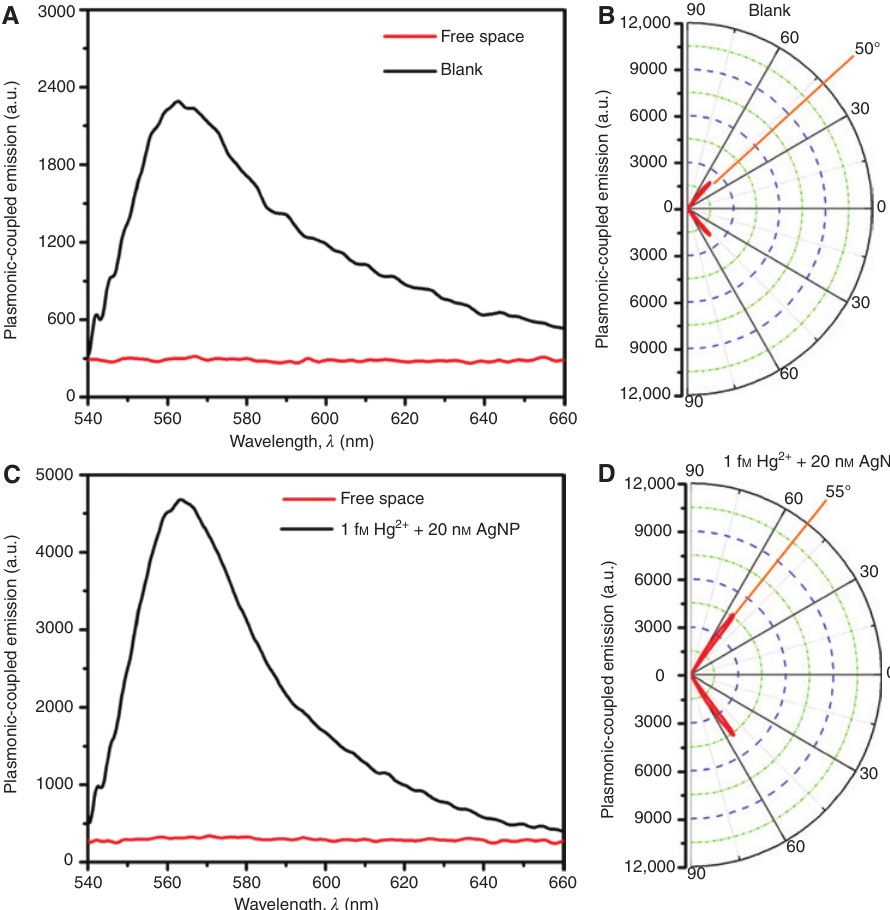
Figure 5: In the presence of the AgNP spacer layer, (A) SPCE and FS intensity of Rh6G D in the absence of Hg 2 + ; (C) SPCE and FS intensity of Rh6G D in the presence of Hg 2 + ; and SPCE radial plots for (B) blank and (D) 1 fm Hg 2 +